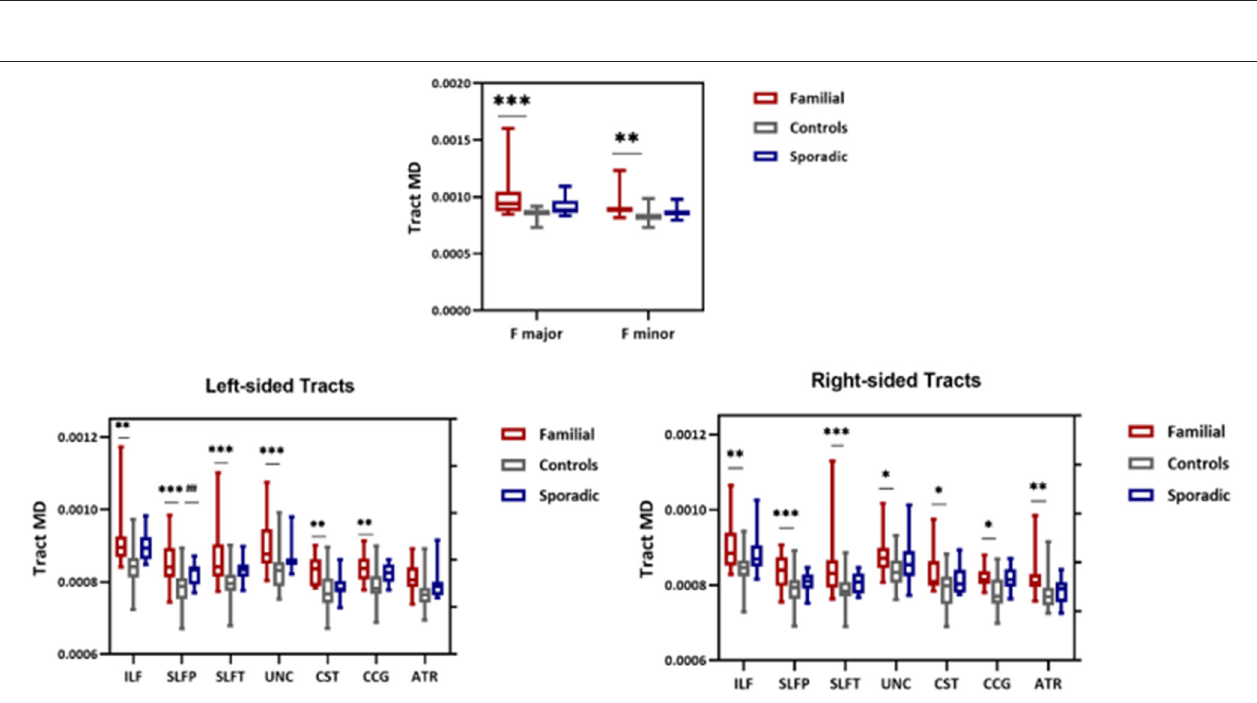
FIGURE 6 | MD values from TRACULA tracts Fmajor, Fminor, ILF, SLFT, SLFP, UNC, CST, CCG, and ATR. The plot shows mean MD left and right tracts and Fminor and major of patients with familial MS (red bars), controls (gray bars), and patients with sporadic MS (blue bars). Asterisks and number signs show significantly increased MD values for patients when compared to controls. * p < 0.05; ** p < 0.01; *** p < 0.01; ## p < 0.05.